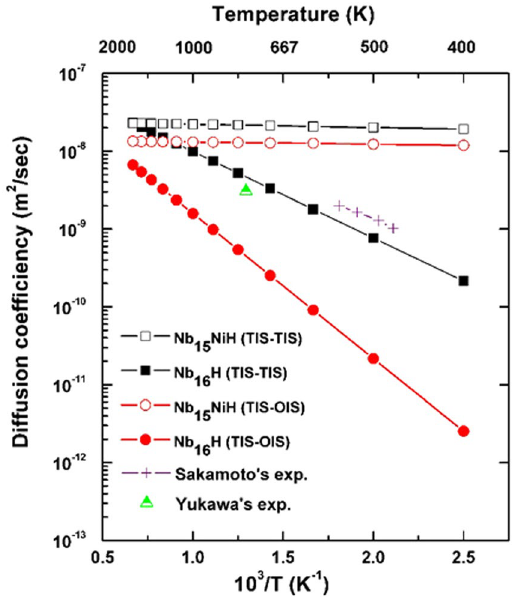
Figure 4. Diffusion coefficients of H along the various paths, as a function of reciprocal temperature. Experimental data are from the work reported by Sakamoto 25 and Yukawa 26 .